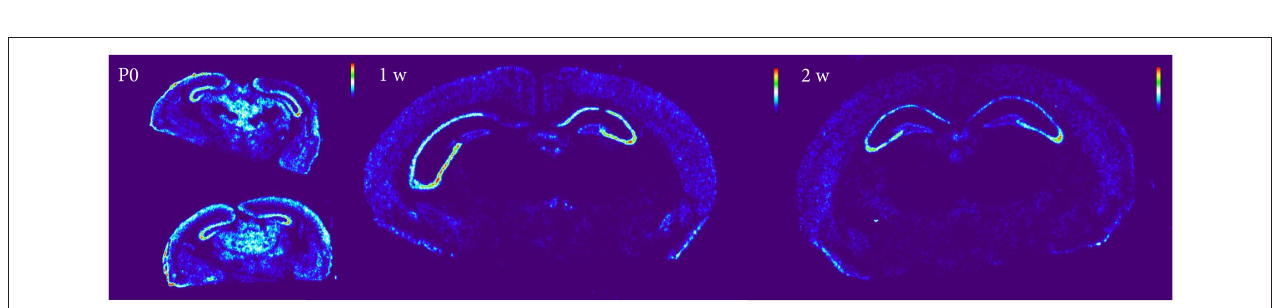
FIGURE 10 | Heatmap of Nogo-A sections at P0, 1 and 2 weeks, demonstrating a global decline of mRNA expression during postnatal development.